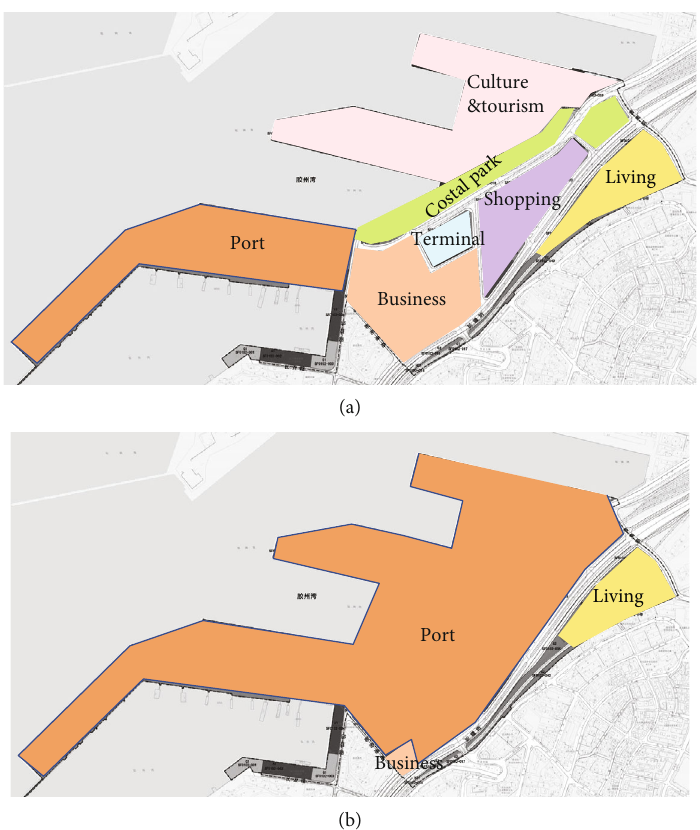
Figure 3: (a) The current land use map; (b) the land use planning map (source: self-created per the relevant information).